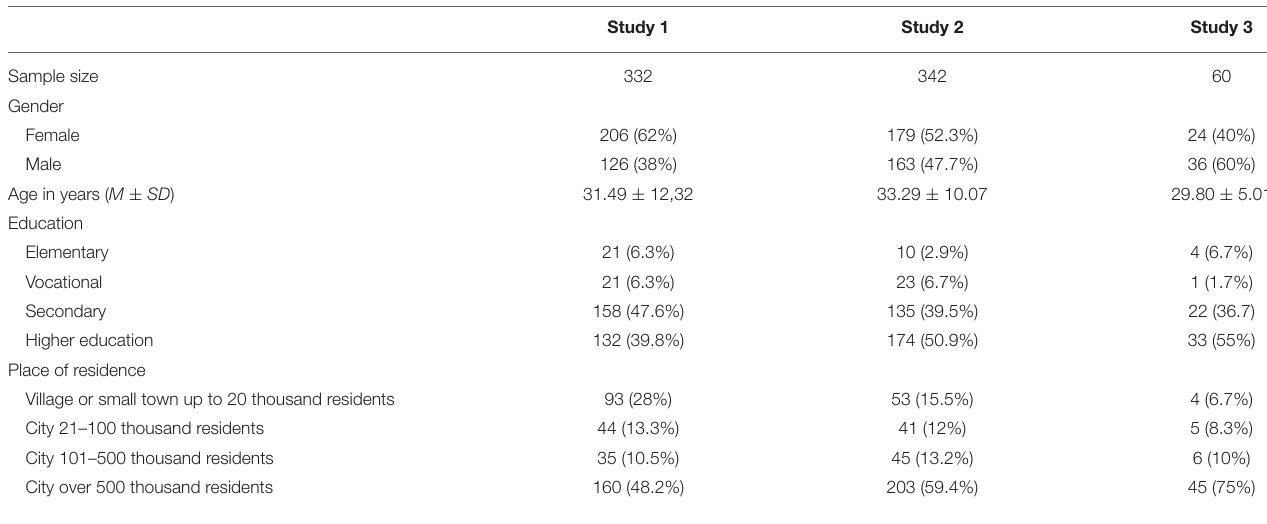
TABLE 1 | Summary of the characteristics of the tested samples, Study